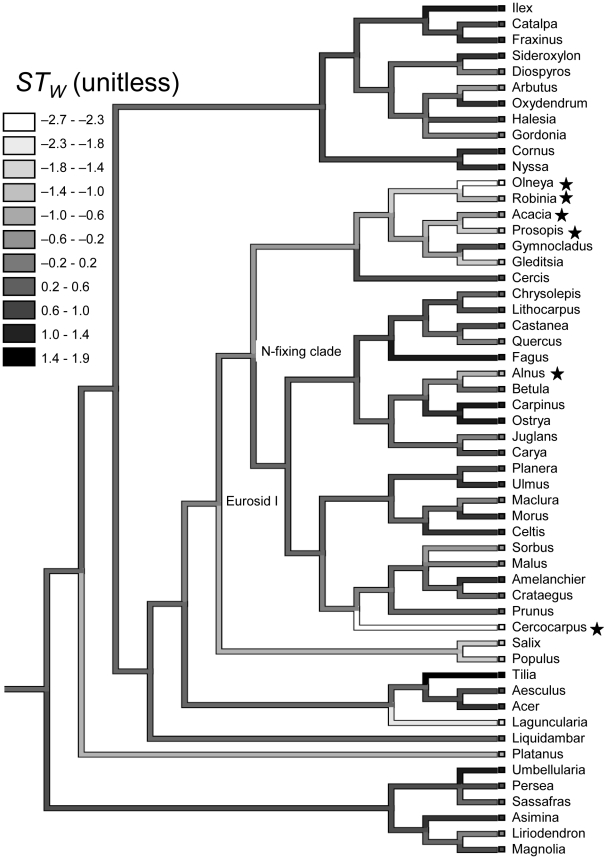
Character history reconstruction of the weighted shade-tolerance index (STW) for native angiosperm FIA genera.The shading indicates the character state of STW, with darker shading indicating greater shade tolerance. STW is the proportion of a taxon's saplings in the FIA data that are in the understory relative to the mean shade tolerance across taxa in 2°×2° grid cells (Fig. S3), and is expressed as the number of standard deviations from the overall angiosperm mean (see Methods for details). The six genera that form N-fixing symbioses are starred: Olneya, Robinia, Acacia, and Prosopis (Fabaceae); Cercocarpus (Rosaceae); and Alnus (Betulaceae). Two clades are indicated: the Eurosid I clade and the ‘potentially N-fixing clade,’ the smallest clade that includes all N fixers (the monophyletic subclade of the Eurosid I that excludes the Malpighiales). To create this figure we used the Trace Character History function (parsimony method) of the program Mesquite [66].